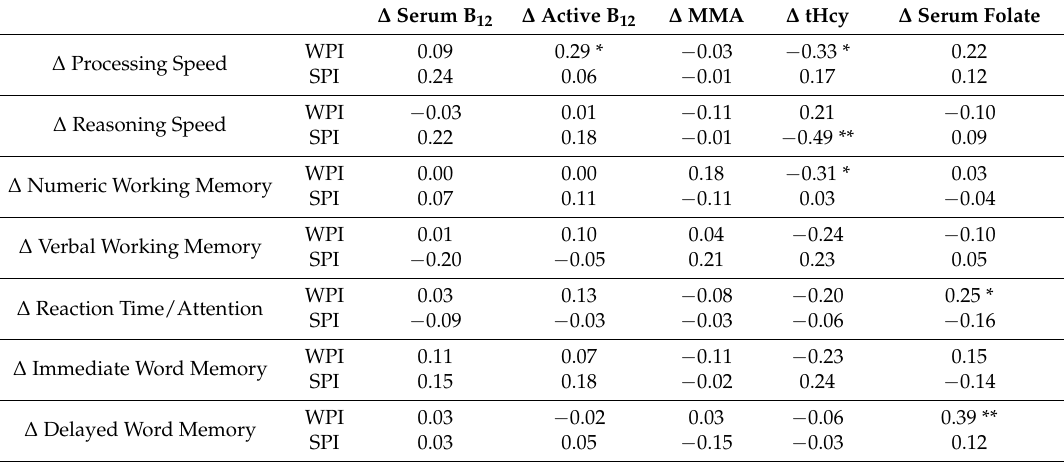
Table 5. Correlations between changes in biometric measures and changes in cognitive function during each treatment period; adjusted for sex and age